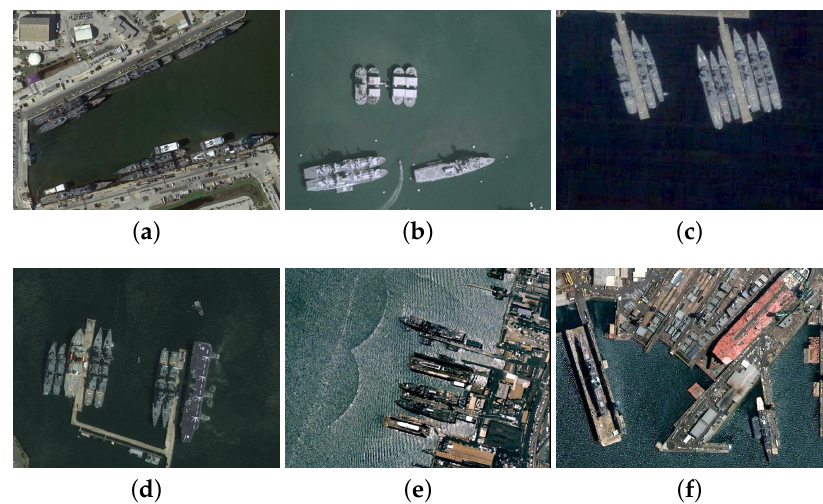
Figure 8. Some images in the ship data set. The ships are in arbitrary orientations, and usually closely docked side by side (see ( a – d ). The background in some images can be very complex (see ( e – f